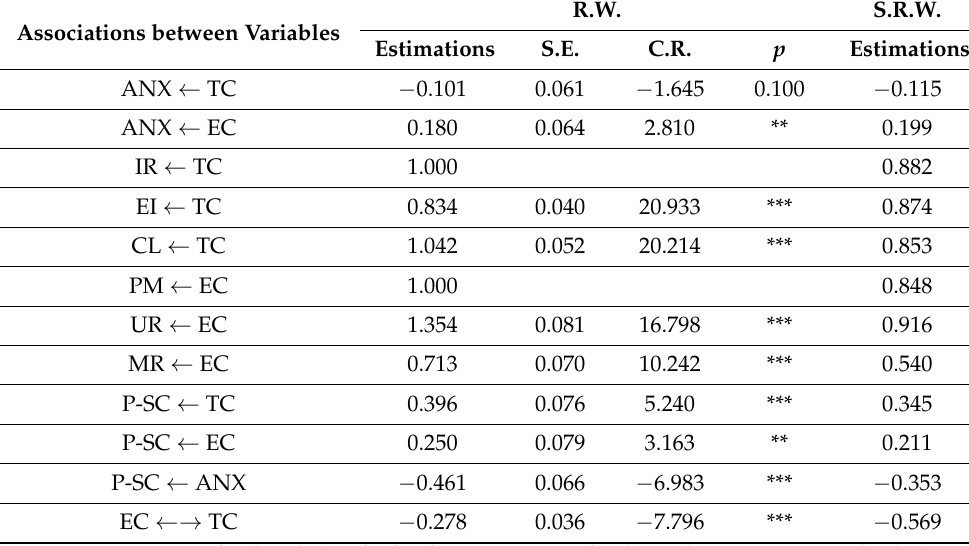
Table 2. Structural model for low adherence to the Mediterranean Diet. Associations between Variables